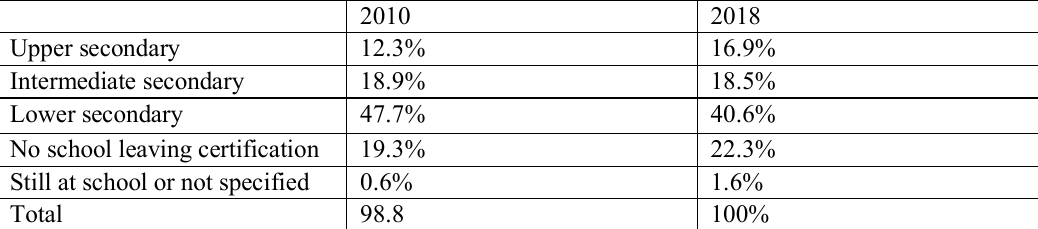
Table 7: Proportions of adults with different degrees of formal education among the low-literate